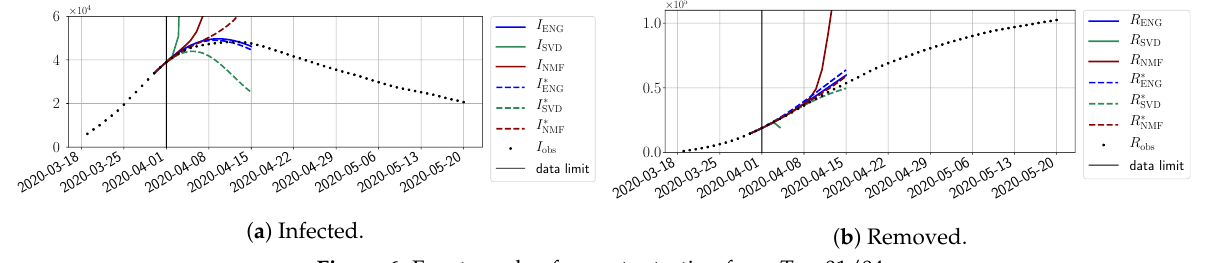
Figure 6. Fourteen-day forecasts starting from T = 01/04.